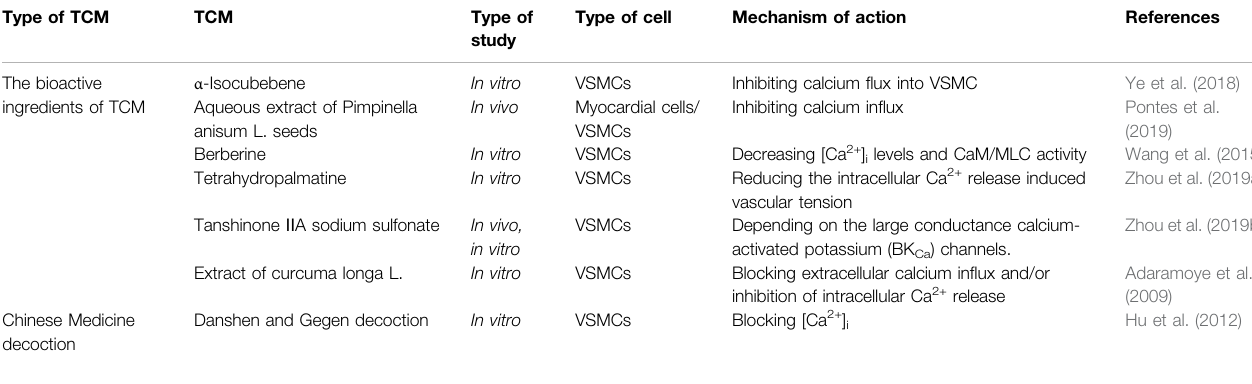
TABLE 3 | The mechanism of TCM in the treatment of hypertensive heart disease through calcium signaling. Type of